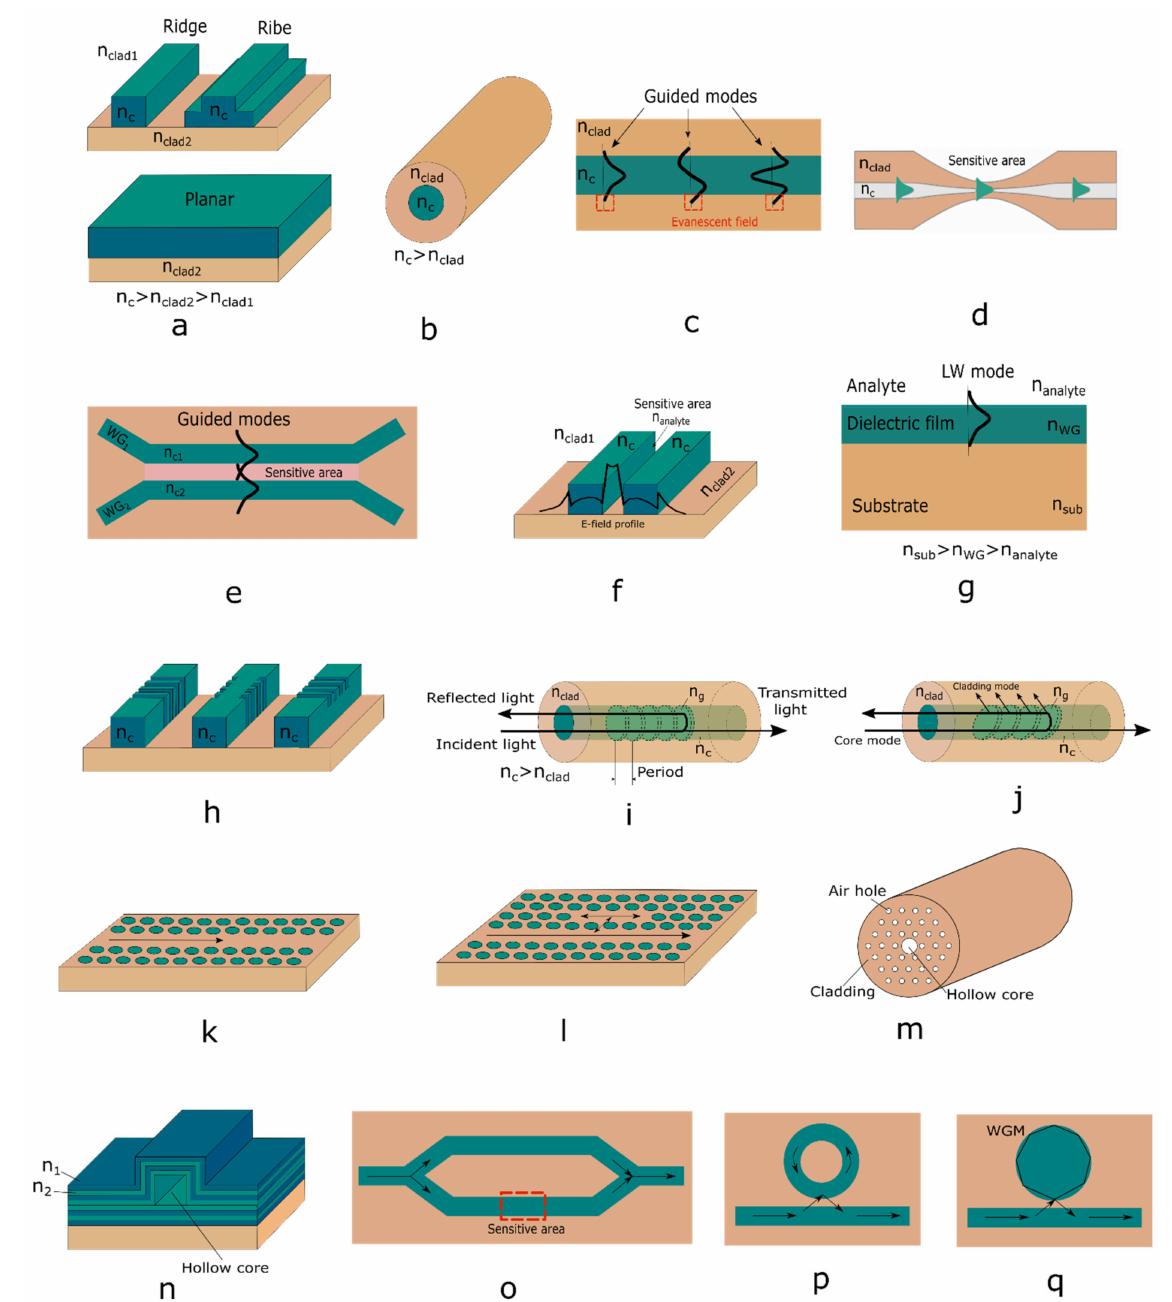
Figure 11. Optical WGs and WG structures in microfluidics. TIR-based WGs: ( a ) rectangular WGs (planar, ridge, rib); ( b ) fiber; ( c ) guided WMs in planar WG; ( d ) tapered fibers; ( e ) coupled waveguides (CWGs); ( f ) slot WGs; ( g ) leaky WGs (LWs). RI-modulated WGs: ( h ) Bragg grating WGs; ( i ) FBG; ( j ) TFBG; ( k ) PC-based WG (PC WG); ( m ) h-PCFs; ( n ) ARROWs. Resonance WG structures: ( l ) PC cavities with coupled PC WG; ( o ) waveguide-based Mach-Zehnder interferometer (MZI); ( p ) microring resonator; ( q ) microdisk resonator with whispering gallery modes (WGM)). Typically, WGs consist of a solid cladding and core or only a solid core (solid-state WGs). In the second case, the environment plays the role of a shell. Both the cladding